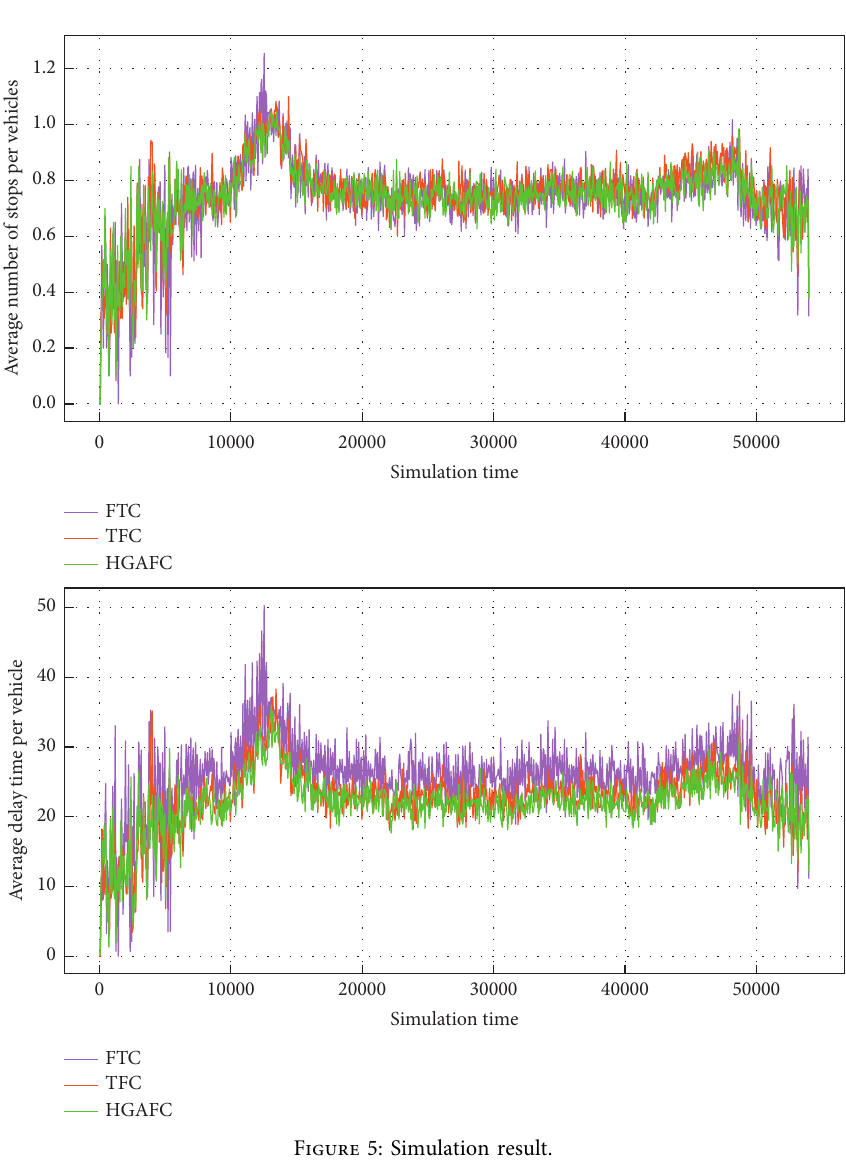
Figure 5: Simulation